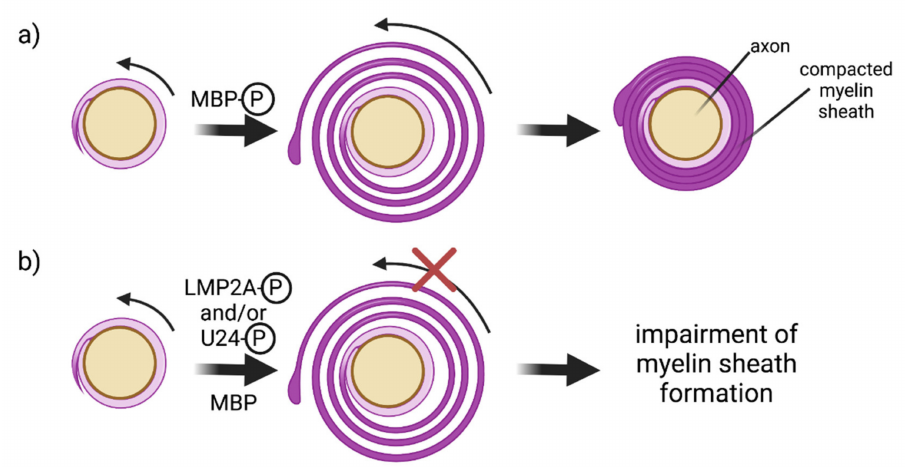
Figure 3. Hypothesis of how a decreased level of phosphorylation of MBP in MS patients could impact myelinogenesis in the CNS by oligodendrocytes. ( a ) Steps involved in myelinogenesis in the case of healthy patients. Adapted from Chang et al. [171]. ( b ) Hypothetical scenario in MS patients, where a decrease in MBP phosphorylation arises because of competition with viral proteins LMP2A from EBV and U24 from HHV-6. Unphosphorylated MBP should have stronger